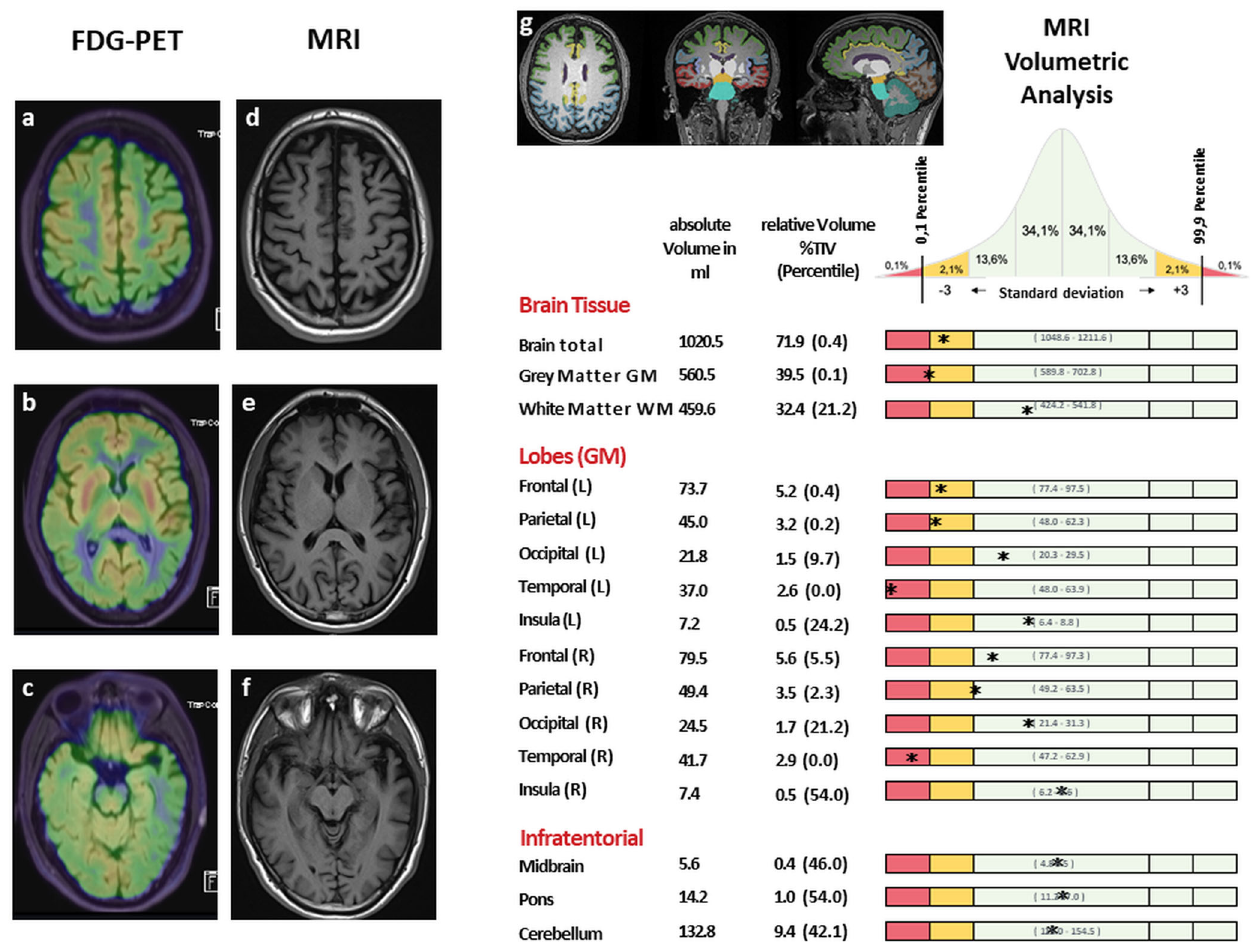
Fig. 2 PET-MRI in the SNCA Triplication Patient. [ 18 F]FDG-PET showed bilateral hypometabolism in frontal ( a ), temporoparietal ( a = parietal, c = temporal), and occipital ( b ) regions as well as of the precuneus and gyrus cinguli posterior. Contrary, the basal ganglia showed an increased metabolism ( b ). Corresponding to the functional hypometabolic pattern in FDG-PET, MRI showed predominantly left-sided frontal ( d ) and temporoparietal ( d = parietal, f = temporal) atrophy while the basal ganglia appeared normal ( e ). Automated brain tissue and lobe segmentation with volumetric analysis using the AIRAmed software ( g ). * indicates the SNCA Triplication patient's individual brain volume pattern corrected for total intracranial volume and compared (plotted as standard deviation) to an age and sex matched healthy control group that consists of over 8000 healthy brains from 18 to 85